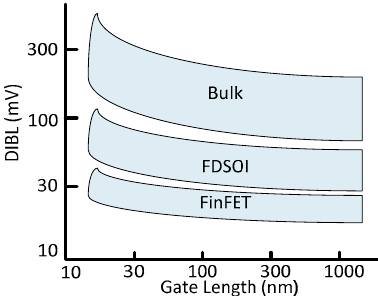
Figure 16. DIBL in bulk fully depleted silicon on insulator (FDSOI) and FinFET [54].